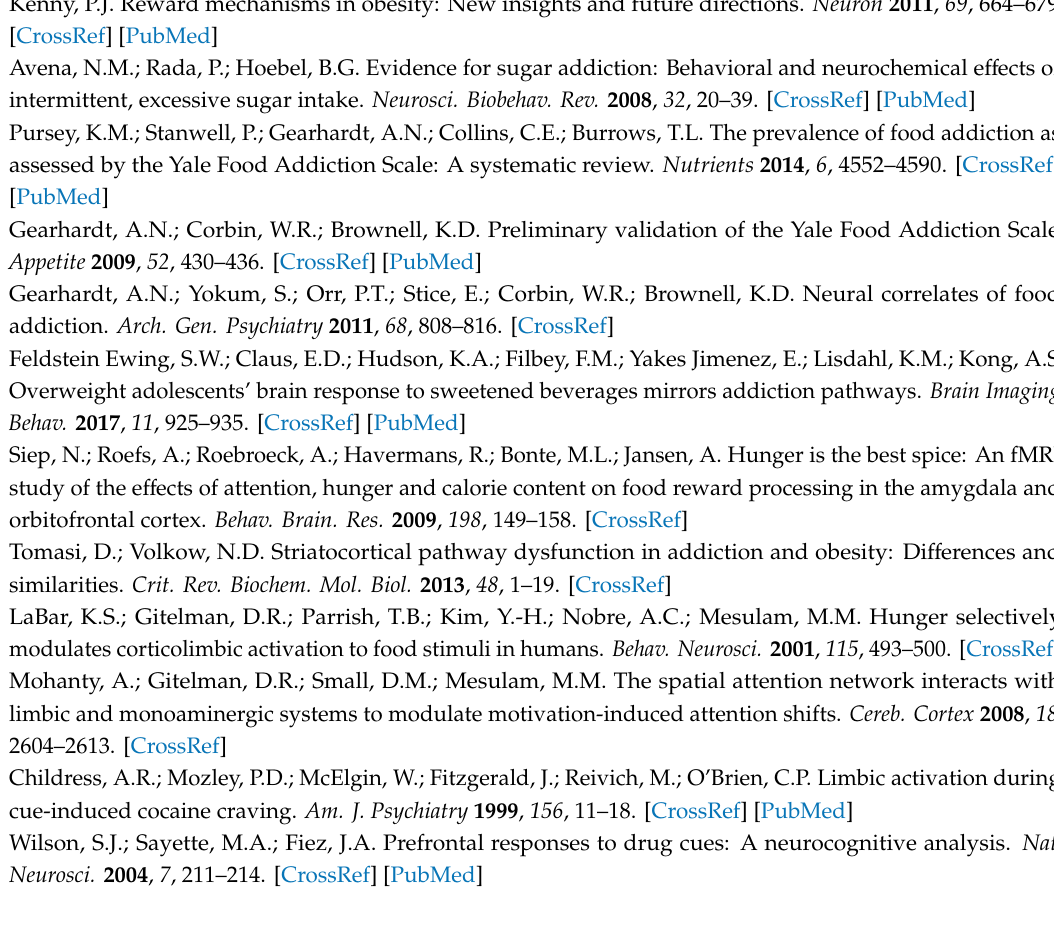
Table S1: Nutritional composition of food image groups per 100 g. Author